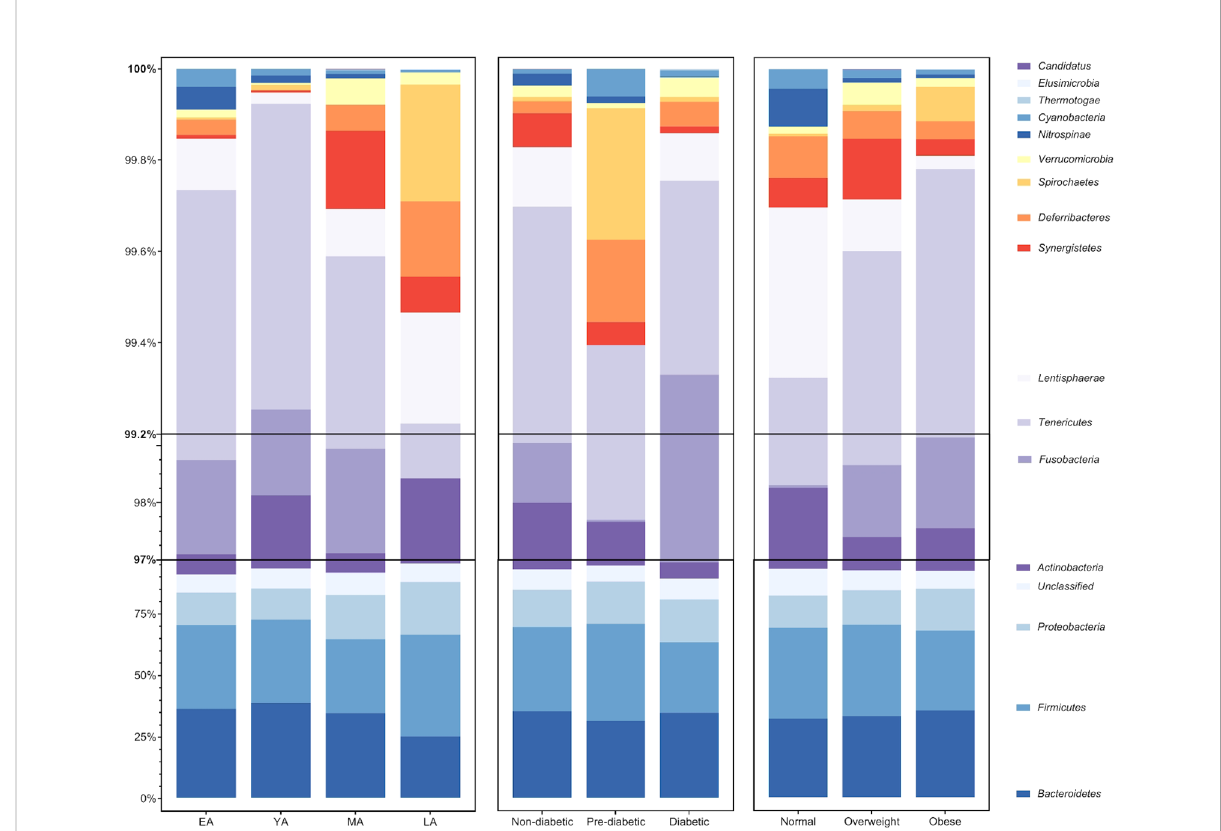
FIGURE 4 Average relative abundance of gut bacterial phyla across age groups, T2DM categories, and BMI categories. Bacterial phyla Bacteroidetes, Firmicutes, Proteobacteria , and Actinobacteria (among unclassi fi ed bacteria) largely compose an average of roughly 97% of the gut bacterial population in each group. The remaining 3% of gut bacteria are largely composed of members belonging to 12 additionally identi fi ed phyla: Fusobacteria, Tenericutes, Lentisphaerae, Synergistetes, Deferribacteres, Spirochaetes, Verrucomicrobia, Nitrospinae, Cyanobacteria, Thermotogae, Elusimicrobia , and Candidatus Thermoplasmatota